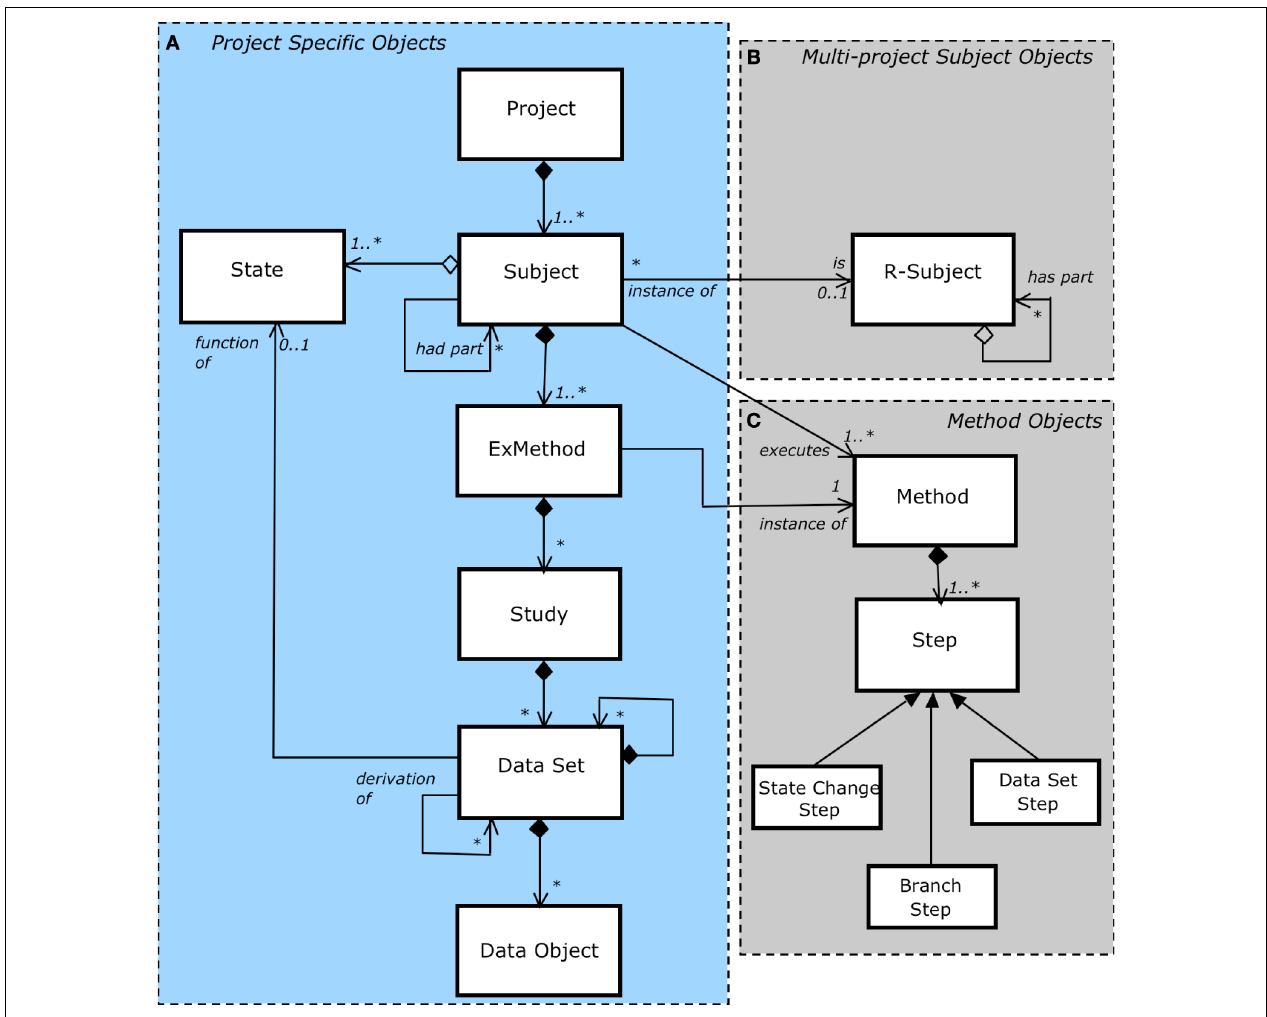
FIGURE 2 | UML object diagram of the Framework object model (see Table 1 for defi nitions). (A) When subjects are not re-used across multiple projects, only the project specifi c objects are used. (B) If subjects participate in